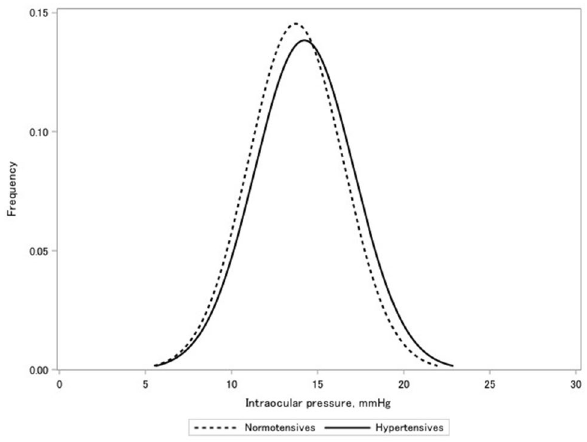
Figure 1. Distribution of intraocular pressure according to hypertensive status.